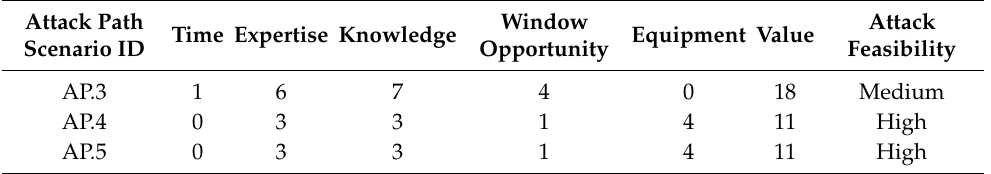
Table 5. Sample of attack feasibility rating for damage scenario in which attacker modifies transmit- ted data.